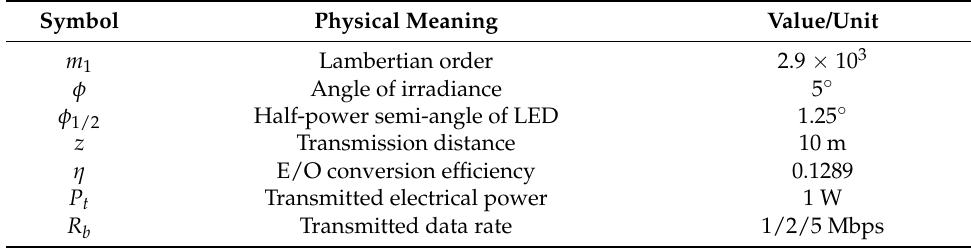
Figure 5. Experimental setup of LED–PMT UOWC system with 5° misalignment between transmitter and receiver. PRBS: pseudo-random bit sequence, AWG: arbitrary signal generator. Table 3. Key parameters of the proposed UOWC system.